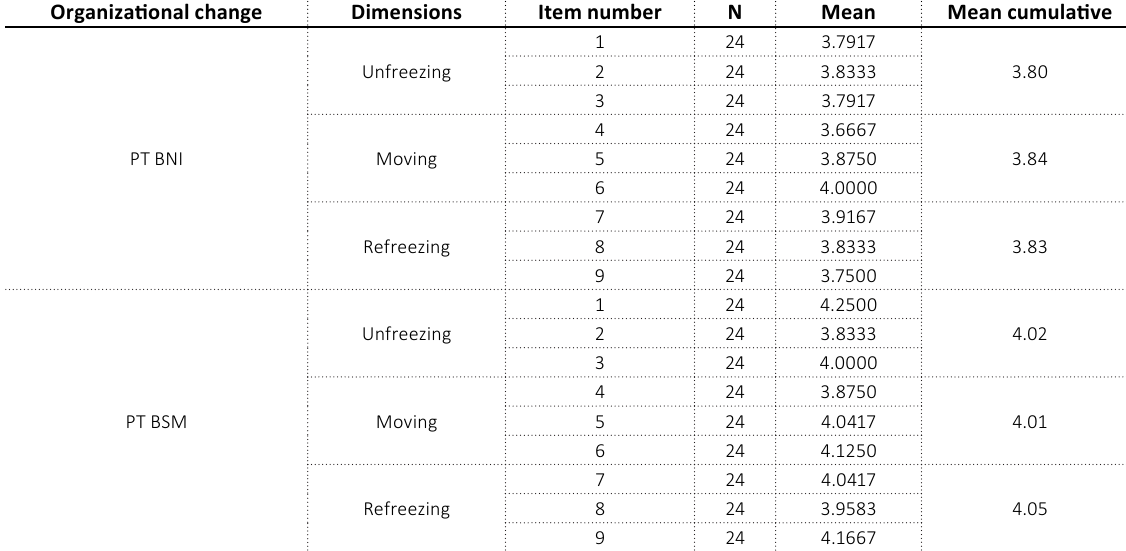
Table 1. Descriptive statistics of organizational change Organizational change Dimensions Item number